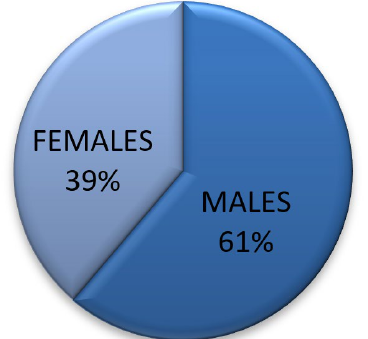
Fig.1. Gender distribution of cases